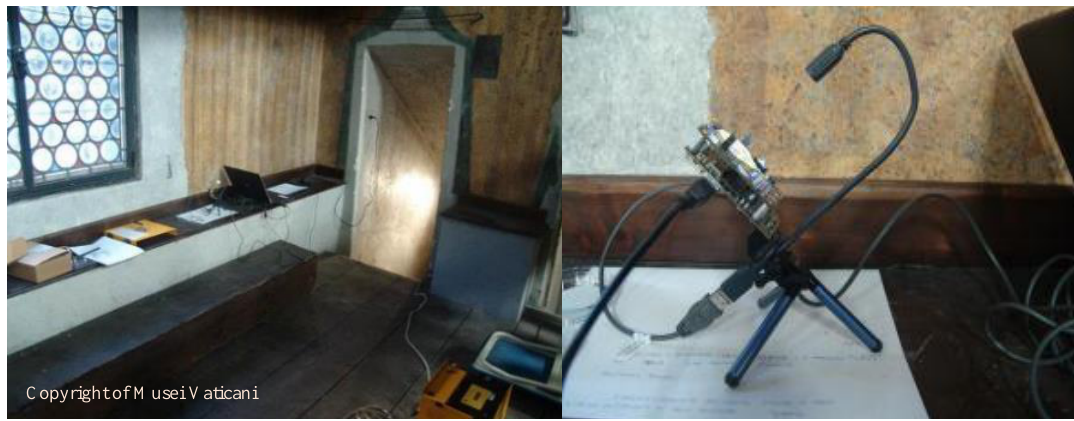
Figure 7. The acquisition device placed inside the ―Cantoria‖ of the Sistine